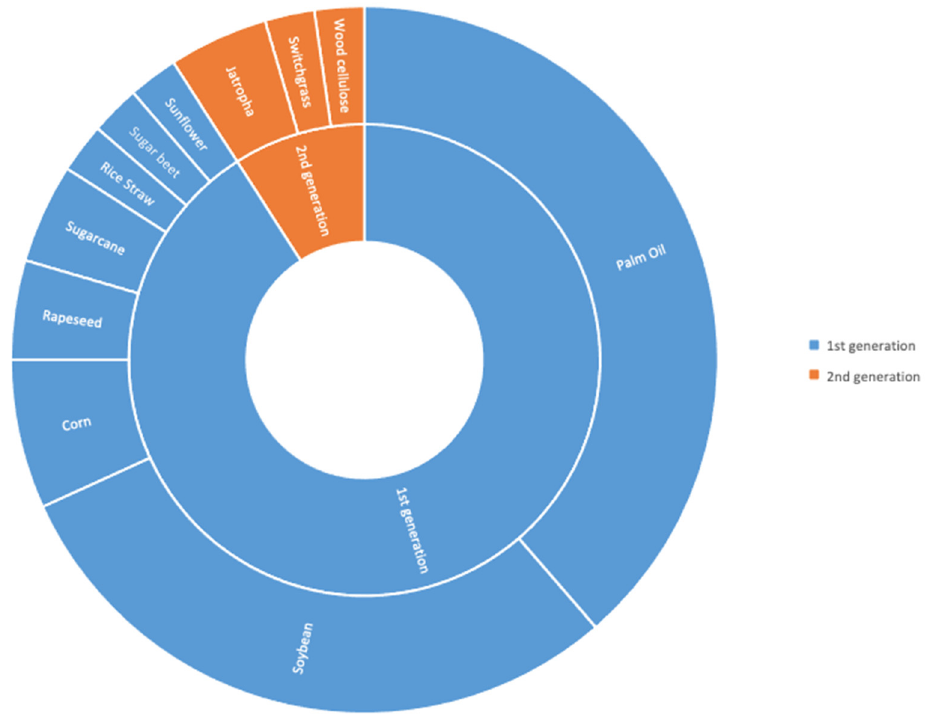
Figure 2. Biofuel projects observed according to biofuel generations and type of feedstocks. Source: authors.